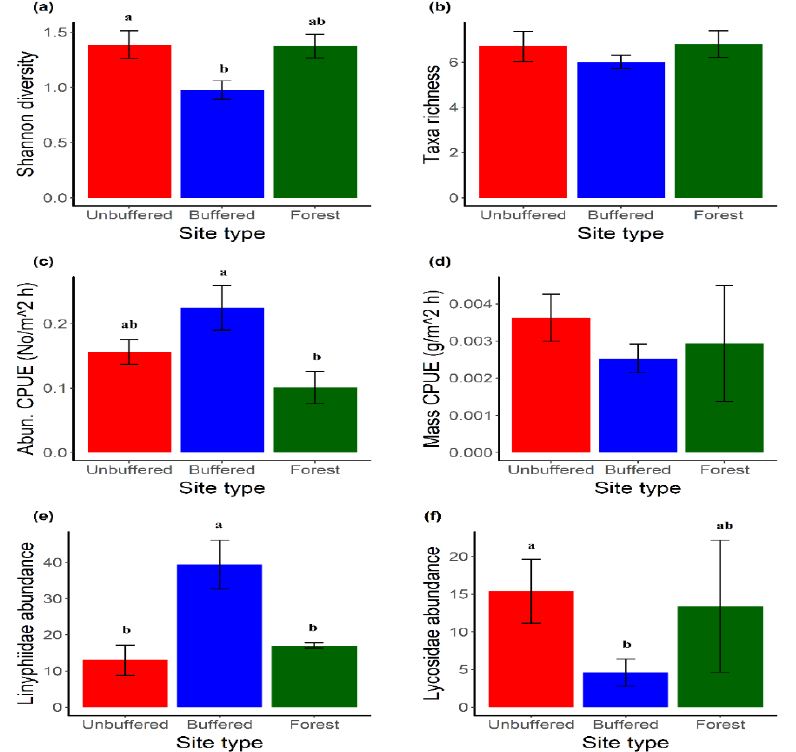
Figure 2. Spider communities: mean ± SE per site type (Unbu ff ed, Bu ff ered, Forest) for ( a ) Shannon diversity, ( b ) Taxa richness, ( c ) abundance CPUE (Catch per unit effort), ( d ) biomass CPUE , ( e ) Linyphiidae abundance, and ( f ) Lycosidae abundance. Letters above the bars denote homogenous subsets based on Tukey’s post-hoc testing of differences among groups.